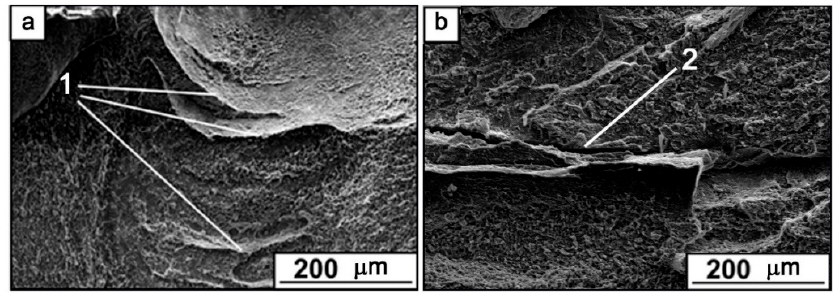
Figure 15. SEM SE fractography images of the FSPed Ti6Al4V ( a ) and Ti6Al4V/Cu ( b ).